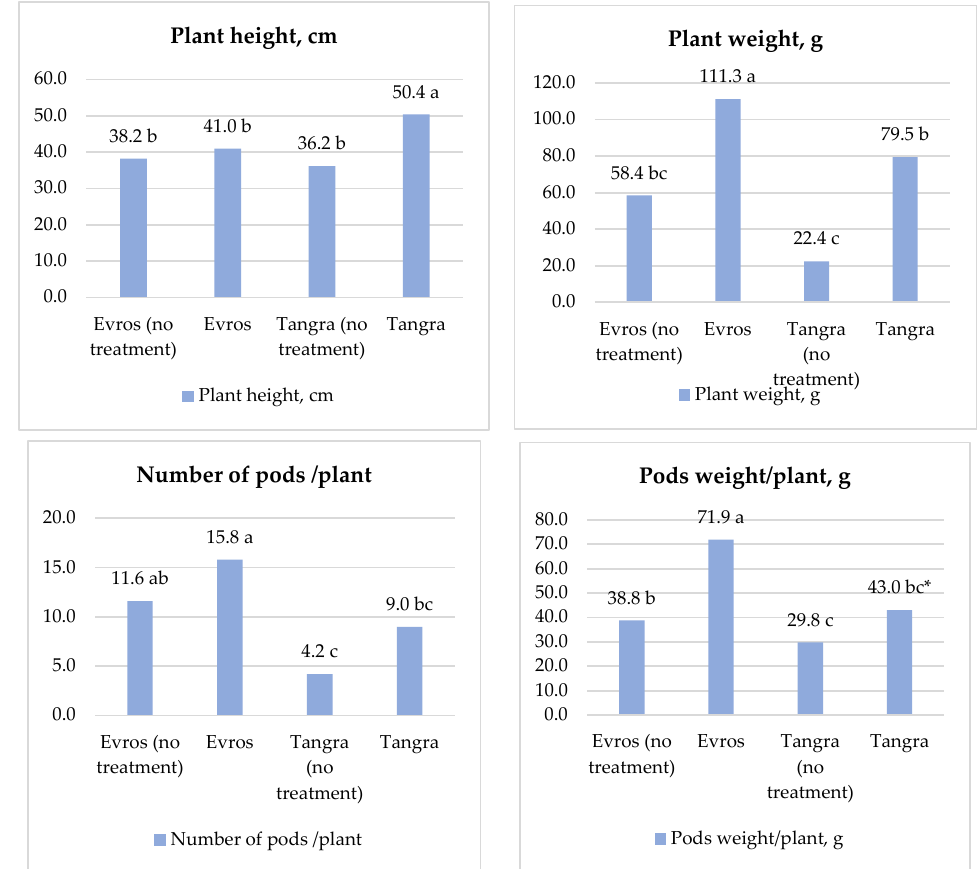
Figure 3. Biometric measurements of snap bean varieties grown in organic field at technological maturity (fruit development when beans begin to fill out). * Means, followed by the same letter (a, ab; b, bc) do not differ significantly; different letters (a, b, c) in each chart show significant difference according to Duncan’s multiple range test ( p < 0.05). Table 6. Biometric measurements of green bean varieties grown in organic field at botanical ma ‐ turity (fully ripe stage when beans are hard).